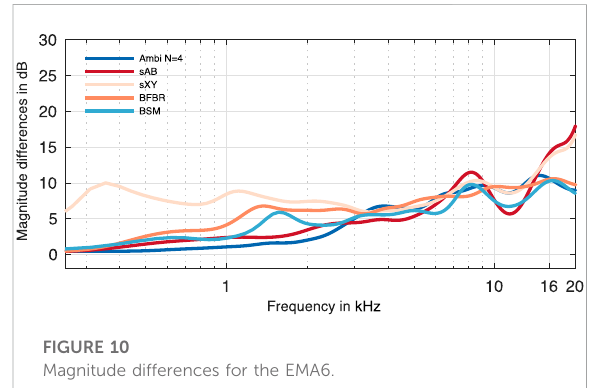
FIGURE 10 Magnitude differences for the EMA6.